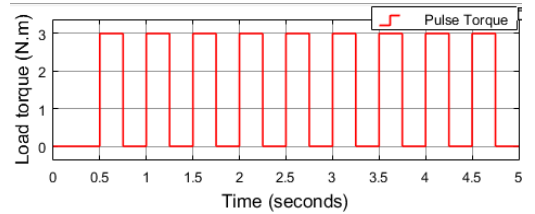
Fig. 9. HPWM technique without current sensors at 5 (N.m) load torque: (a) Reference and actual speed at 10% - 5% rating speed, (b) Three phase estimated currents, (c) Comparison between A phase measured current and estimated current.